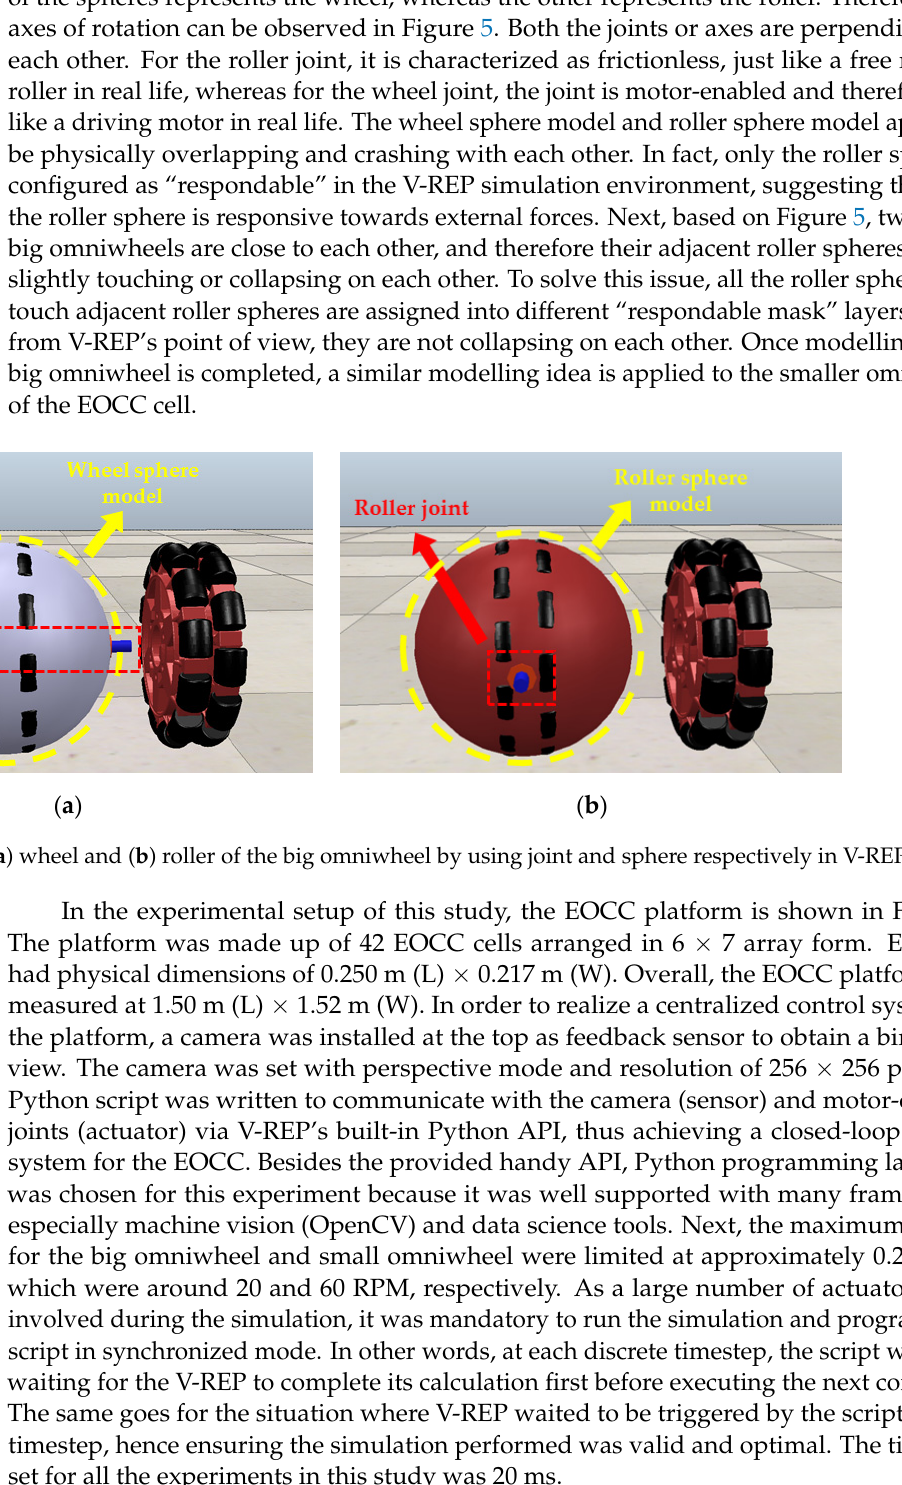
Figure 6. A top view screenshot of the proposed E-pattern omniwheeled cellular conveyor (EOCC) platform in V-REP environment.